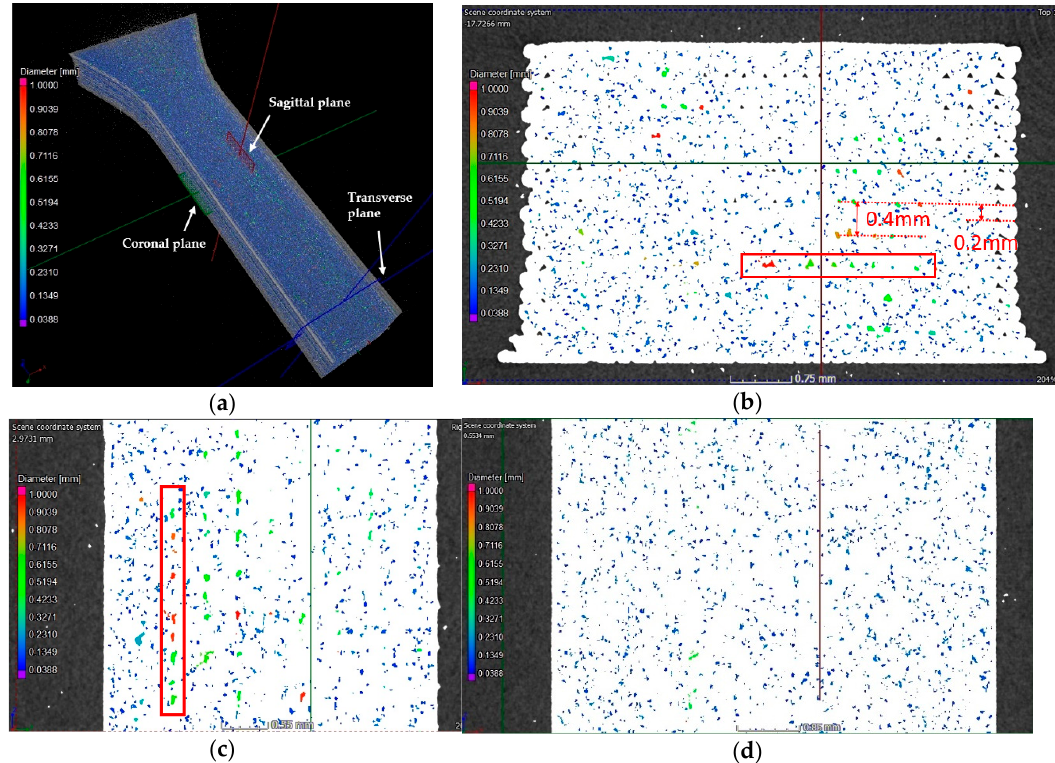
Figure 5. Pore distribution for UPL = 1 mm characterized by X-ray computed tomography (XCT) of three-dimensional visualization in ( a ) and two-dimensional visualization in ( b ) the transverse plane, ( c ) the sagittal plane, and ( d ) the coronal plane. The red slim rectangular in (b) and (c) mark the selected pores of large size between two adjacent layers of the specimen. The distance between the linearly aligned large pores in (b) and (c) was measured as 0.4 mm, which is twice of the layer thickness of 0.2 mm.